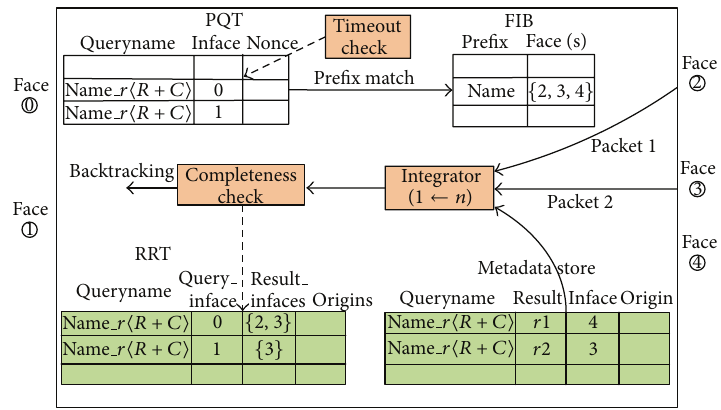
Figure 2: The forwarding and integration engine for relation routing